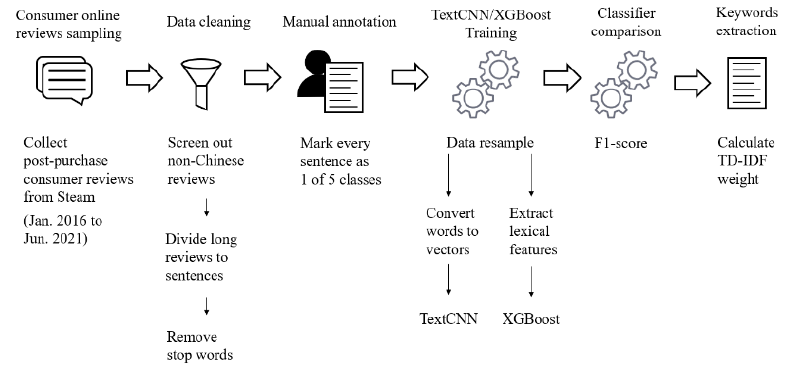
Figure 1. The data processing workflow.